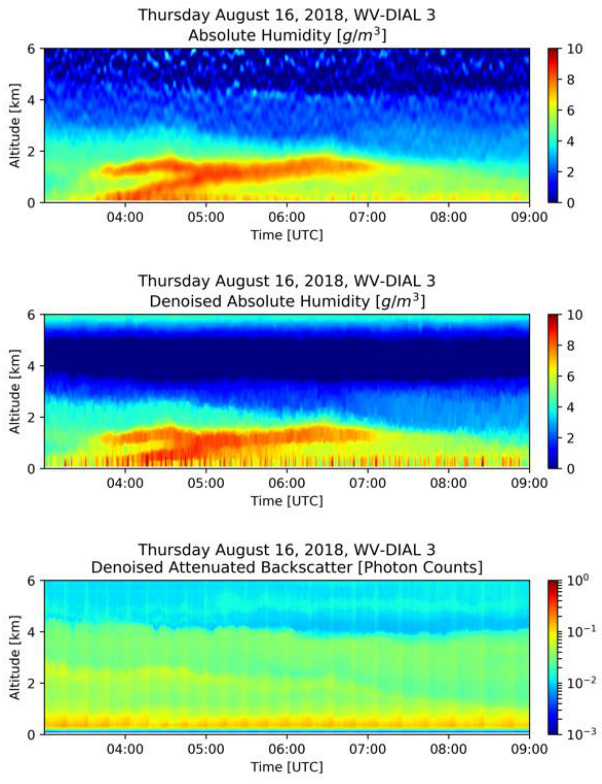
Figure 1: Water vapor estimates from an MPD using the standard inversion (top) and PTV inversion